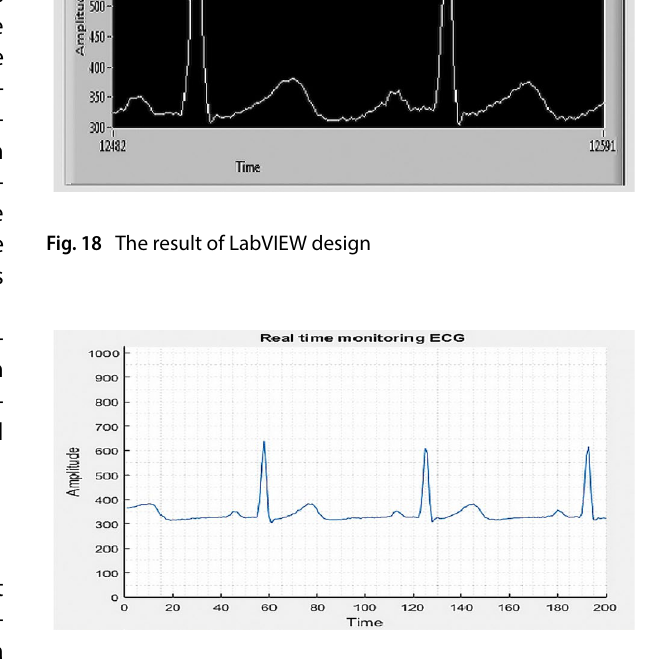
Fig. 19 The results of the MATLAB